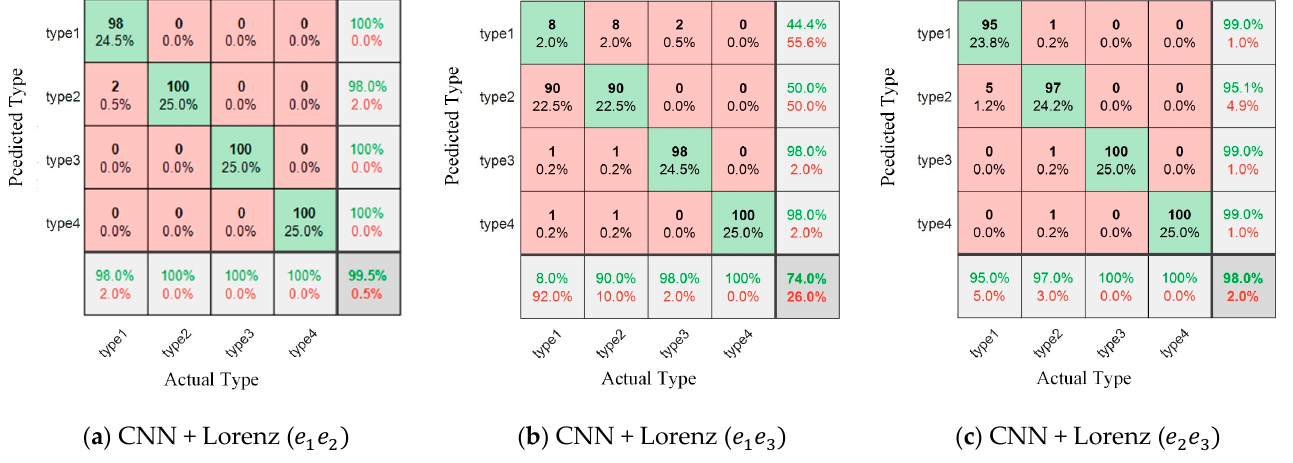
Figure 20. Confusion matrixes of CNN with Lorenz CSDM for fault diagnosis of PV modules.